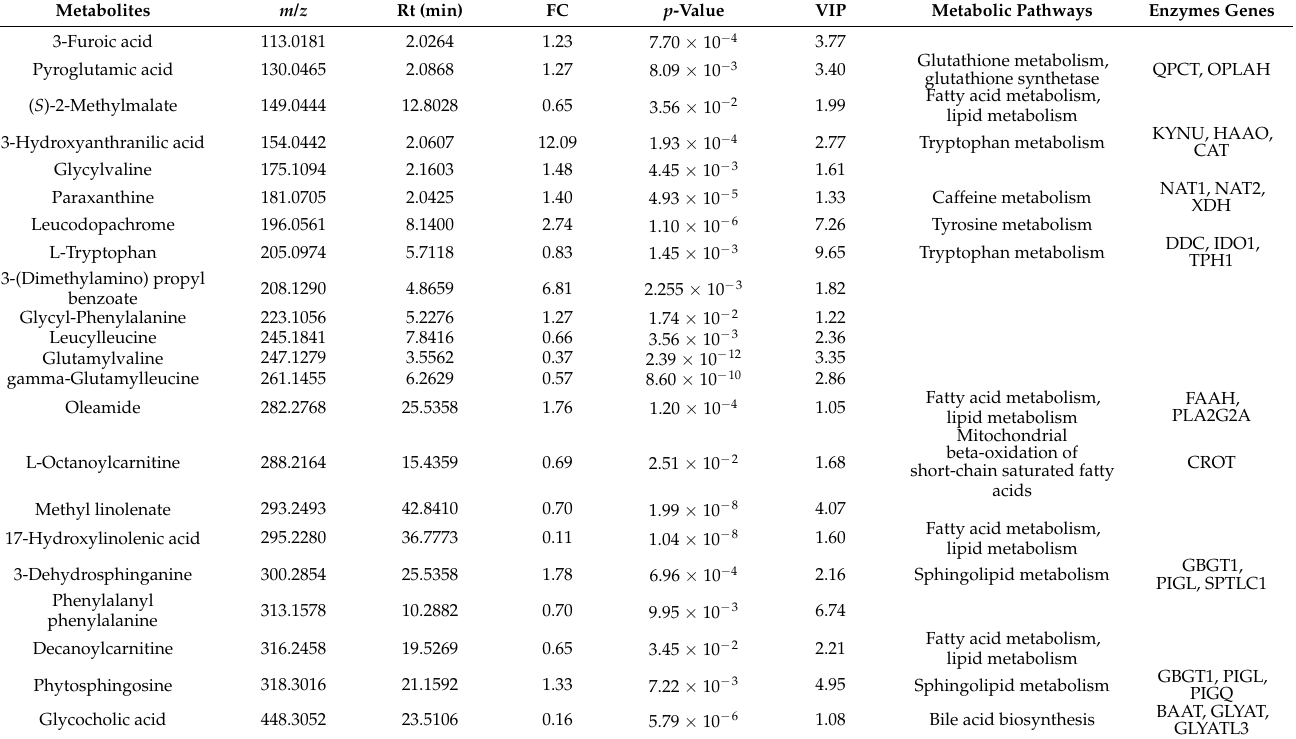
Figure 1. PCA, OPLS-DA score plots, and S-plots of healthy and UC groups based on HPLC-Q-TOF serum analysis. ( A ) PCA score plots of healthy and UC group. ( B ) OPLS-DA score plots of healthy and UC group. Blue represents the healthy group and green represents the UC group. ( C ) S-plot of healthy and UC group. ( D ) Volcano plot of healthy and UC group. Table 2. Key differential metabolites between the healthy and UC